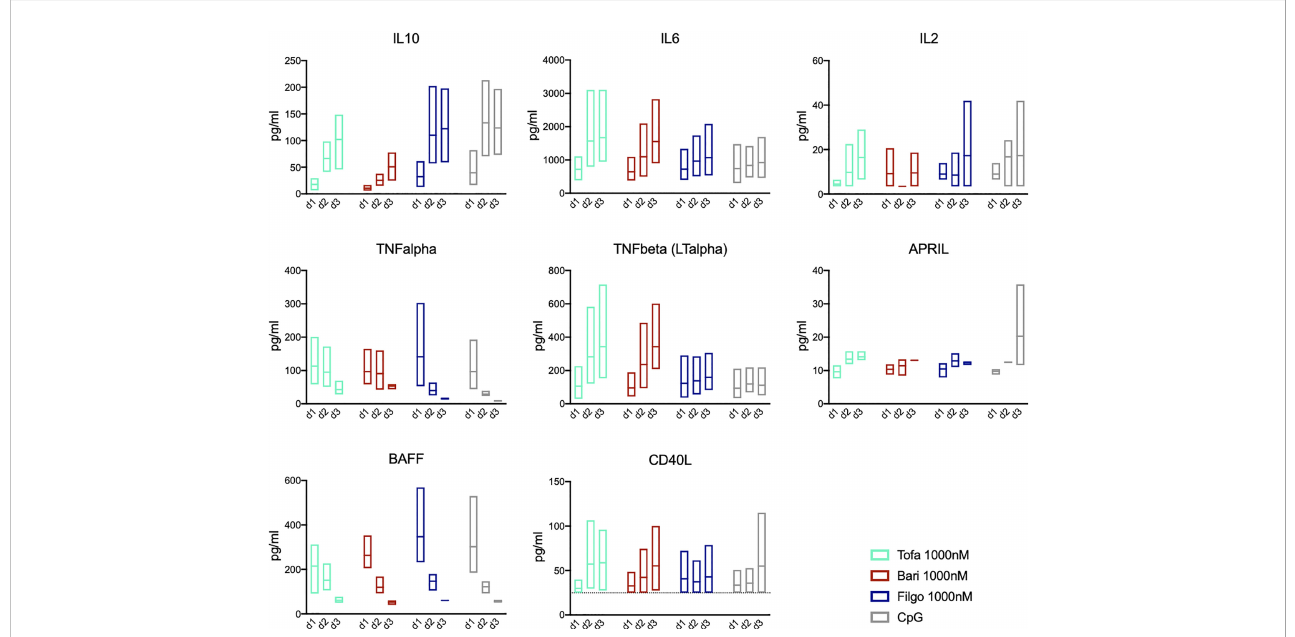
FIGURE 6 JAK inhibition leads to altered cytokine secretion pro fi le. Secretion of IL-10, IL-6, IL-2, TNF- a , TNF-ß (LT- a ), APRIL, BAFF, and CD40L was measured in supernatants of in-vitro B cell culture by cytokine multiplex assay on day 1, 2, and 3 during treatment with Tofacitinib, Baricitinib or Filgotinib. Data depicted as fl oating bars (min to max) with line at